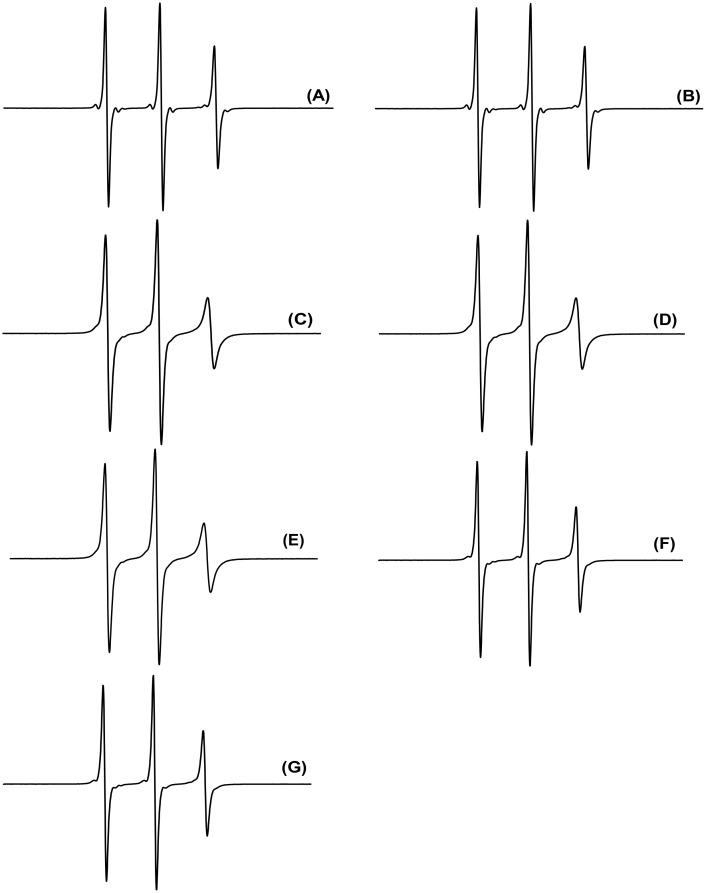
EPR spectra of TOAC0-AngI (A), TOAC1-AngI (B), TOAC3-AngI (C), TOAC5-AngI (D), TOAC8-AngI (E), TOAC9-AngI (F) and TOAC10-AngI (G) in 20 mM phosphate buffer, pH 7.0.Field scan: 100 Gauss.